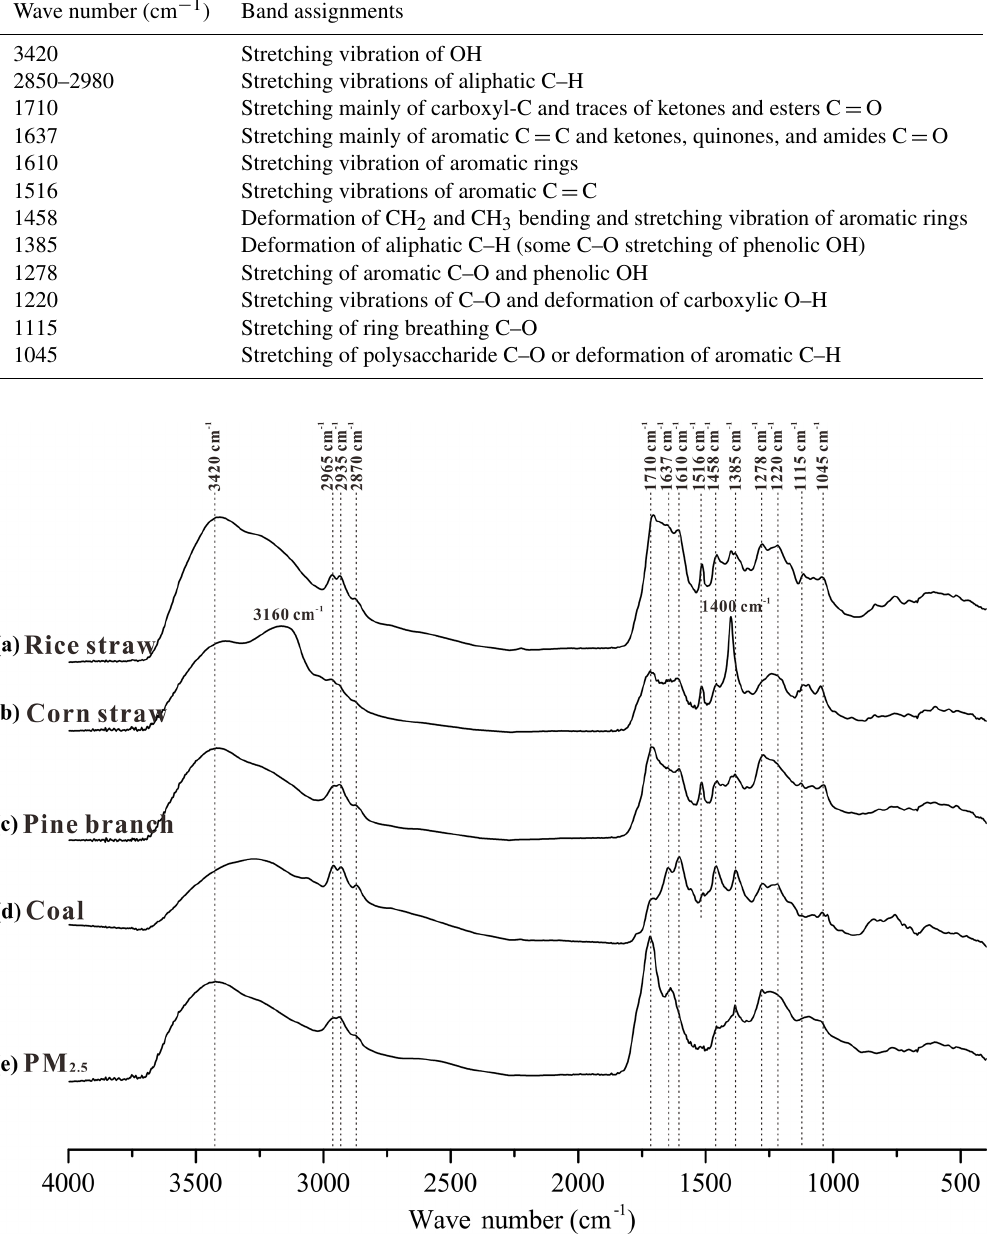
Figure 3. FTIR spectra of primary HULIS in smoke PM 2 . 5 from combustion of rice straw (a) , corn straw (b) , pine branch (c) , coal (d) , and in ambient PM 2 . 5 (e)